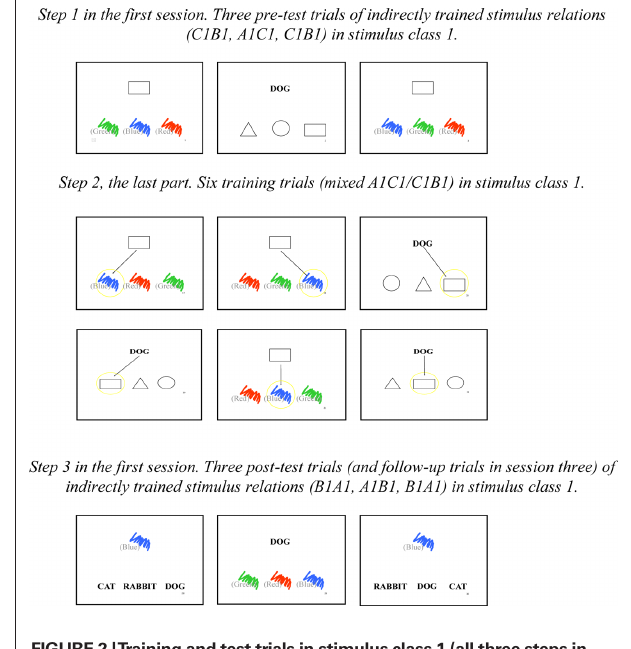
Figure 2 | Training and test trials in stimulus class 1 (all three steps in the first